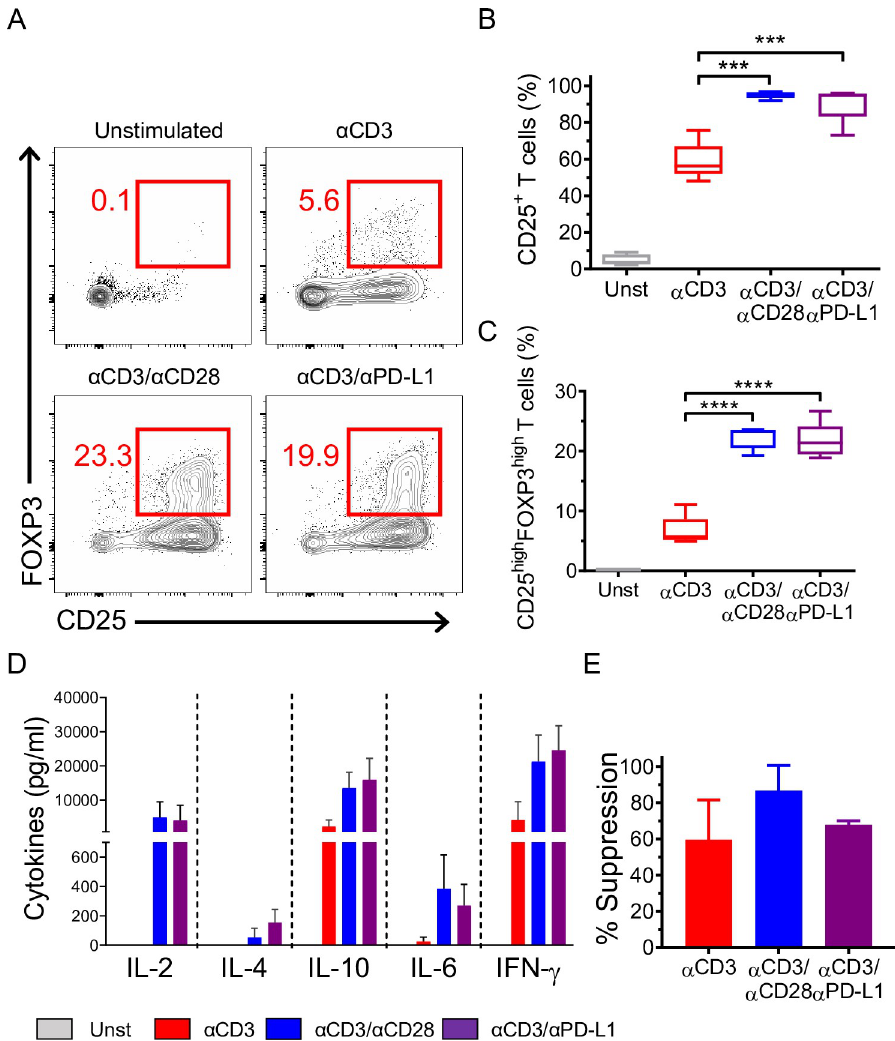
Fig 7. Phenotype, cytokine production, and suppressive ability of RA CD4 + CD25 − T cells upon PD-L1 engagement. ( A ) Representative dot plots showing CD25 and FOXP3 expression after 72 h of culture of CD4 + CD25 − T cells isolated from RA patients under the conditions indicated (left panel). ( B , C ) Quantification of CD25 and FOXP3 expression. Data are represented using boxplots indicating the min and max and median and are pooled from at least 2 independent experiments ( n = 5); ��� P < 0.001 and ���� P < 0.0001 by RM one-way ANOVA followed by Tukey multiple comparison. ( D ) Absolute values of cytokine production by RA CD4 + CD25 − T cells activated under the indicated conditions. ( E ) Suppression of RA CD4 + CD25 − T cells at 1:20 ratio. Data are expressed as mean ± SD and are pooled from at least 2 independent experiments ( n = 3). Values for each data point can be found in S1 Data. Full gating strategies from representative plots are shown in S1 Gating Strategy. PD-L1, PD-1 ligand 1; RA, rheumatoid arthritis; RM, repeated